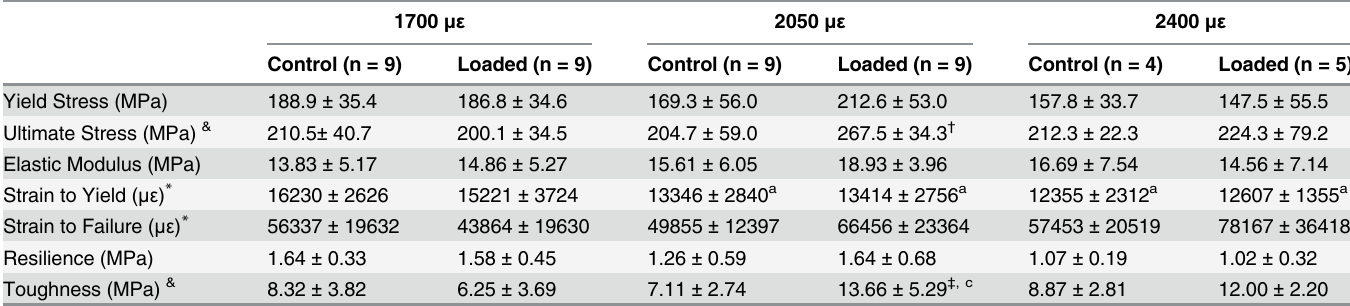
Table 4. Estimated Tissue-level Mechanical Properties From 4-Point Bending of the